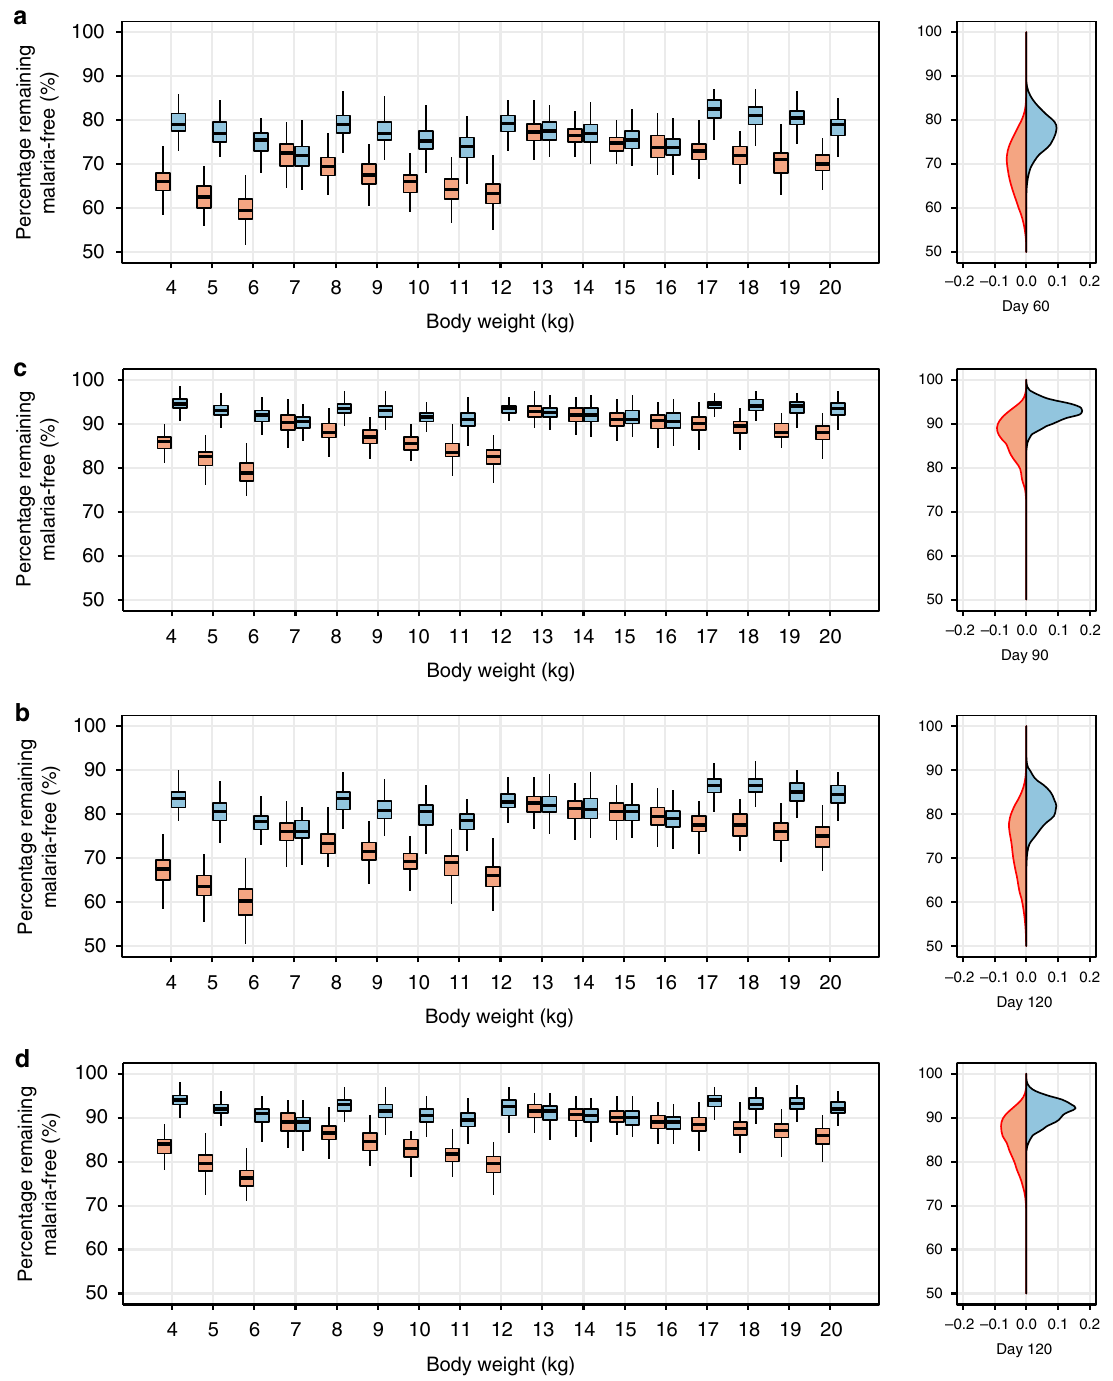
Fig. 4 Comparisons of the expected pharmacodynamic outcomes. a Children (4 – 20 kg) remaining malaria-free after a single treatment regimen by day 60, b children (4 – 20 kg) remaining malaria-free after three rounds of a monthly dose regimen by day 120, c children (4 – 20 kg) remaining malaria-free after three rounds of a monthly dose regimen by day 90, d children (4 – 20 kg) remaining malaria-free after four rounds of a monthly dose regimen by day 120. Red box-whisker plots represent the standard WHO 2010 dosing regimen 52,43 and blue box-whisker plots represent the increased dosing regimens according to the revised WHO 2015 recommendation 26 , strati fi ed by body weight. The simulations are based on 200 individuals per body weight for 100 replications. The box-whisker plots represent the median with inter-quartile range and the 95% prediction interval. Right panels represent the proportions of children remaining malaria-free at the end time point; the red fi lled density plots represent the standard WHO 2010 dosing regimen and the blue fi lled density plots represent the revised WHO 2015 dosing